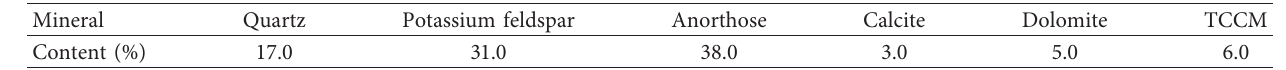
Table 1: Mineral composition of sandstone used in this